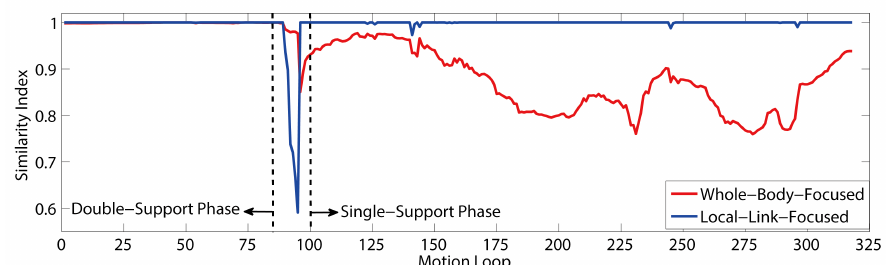
Figure 15. Left-tibia similarity index trajectories in the first experiment as calculated using the two evaluation methods.